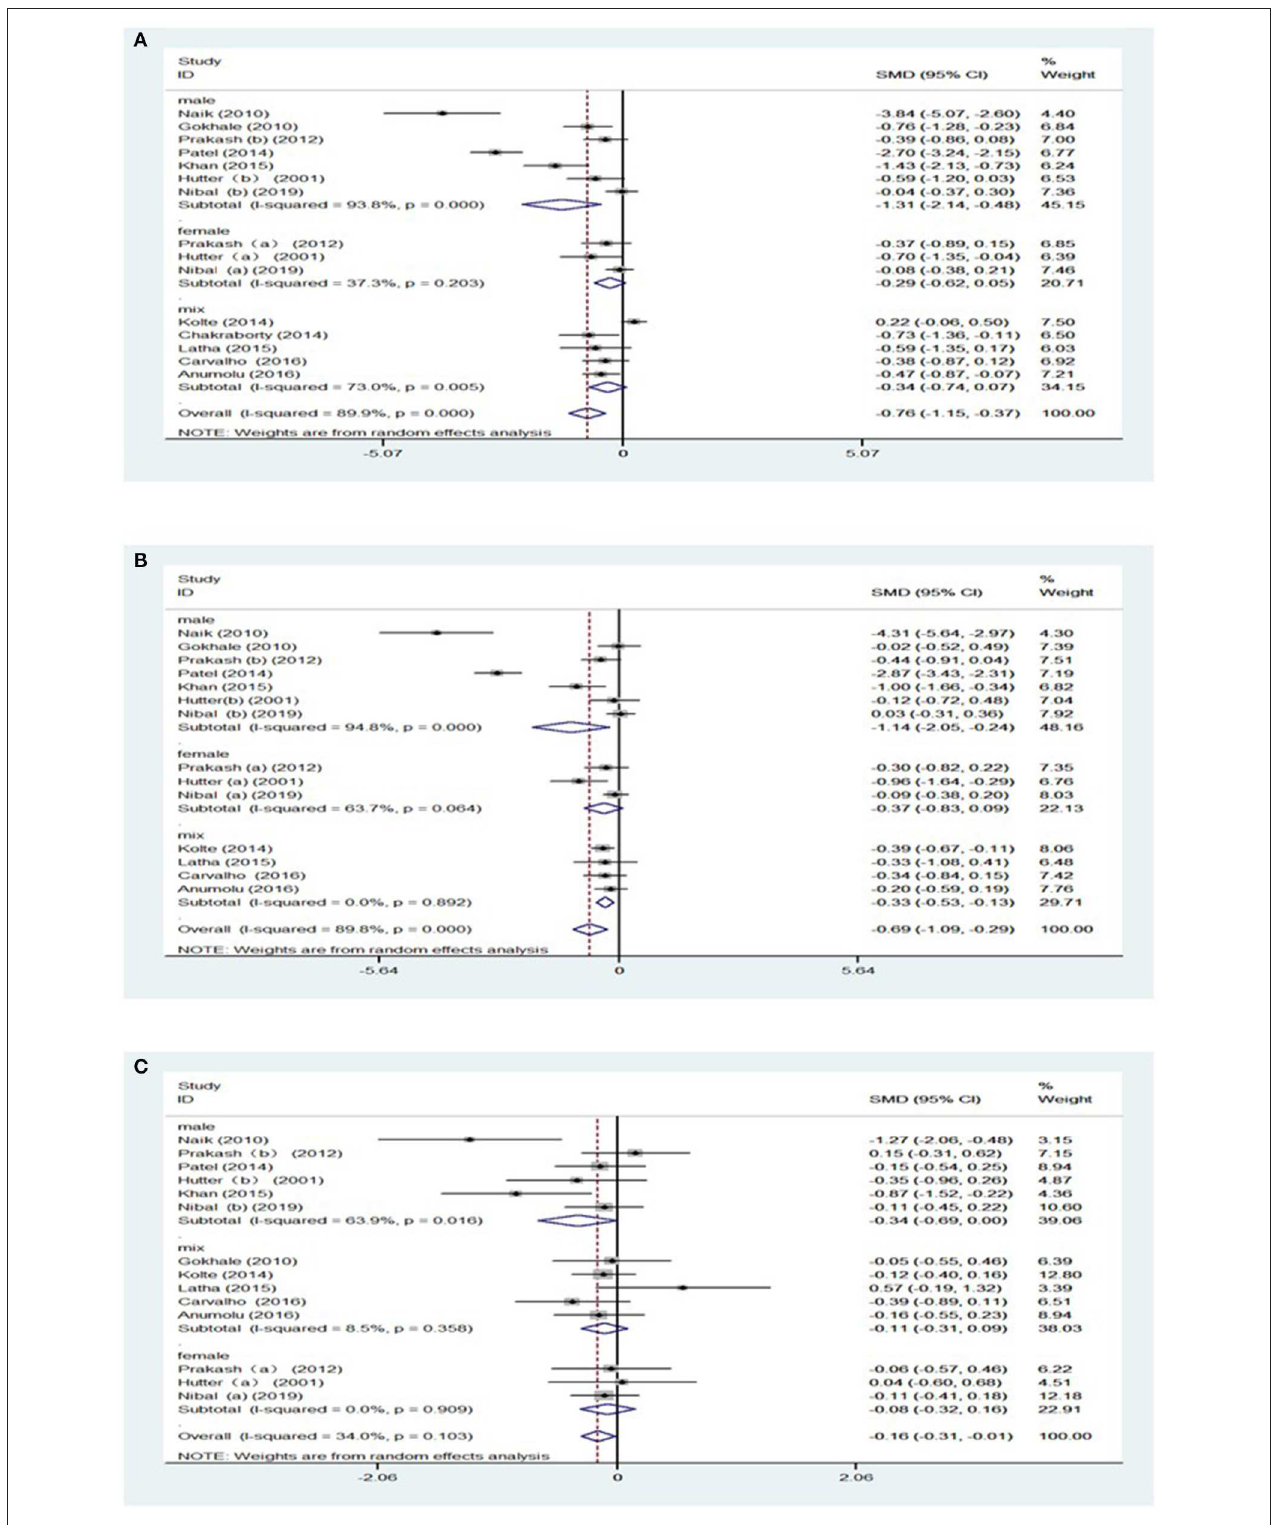
FIGURE 2 | Forest plot of the studies regarding gender. (A) Forest plot of the studies regarding association between Hb and gender; (B) Forest plot of the studies regarding association between RBC counts and gender.; (C) Forest plot of the studies regarding association between MCV and gender. SMD, standardized mean difference; CI, confidence intervals; (a) means of female participants in the studies, (b) means of male participants in studies.